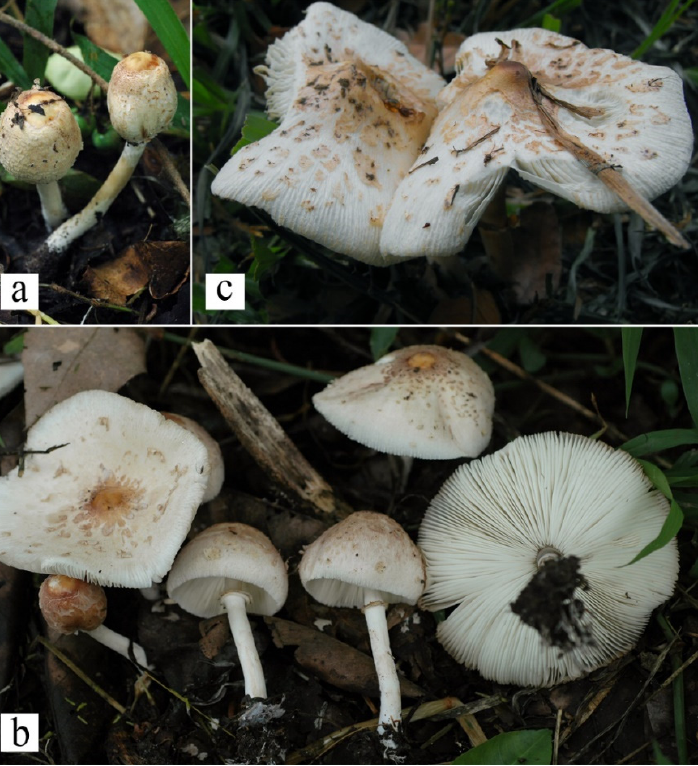
Smell mild. Spore print